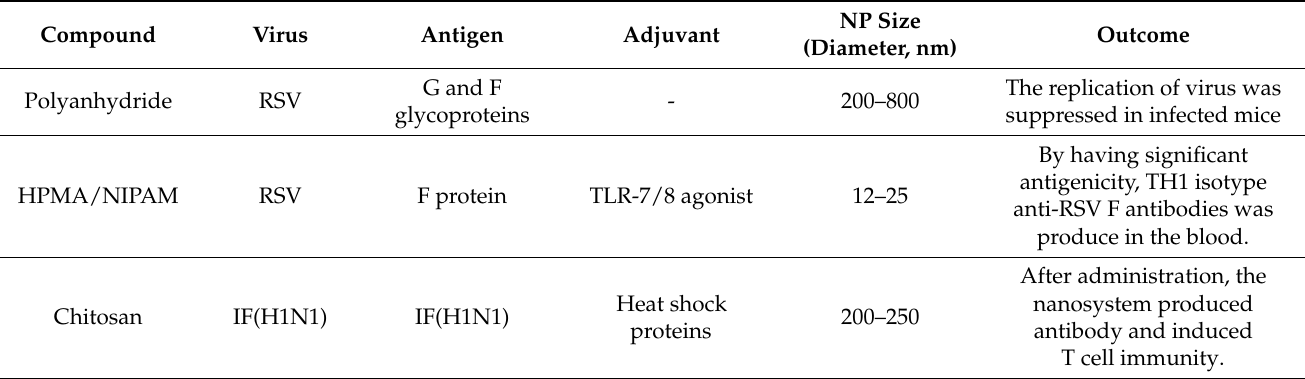
Table 1. Previously used different classes of nanoparticles in respiratory viral diseases.